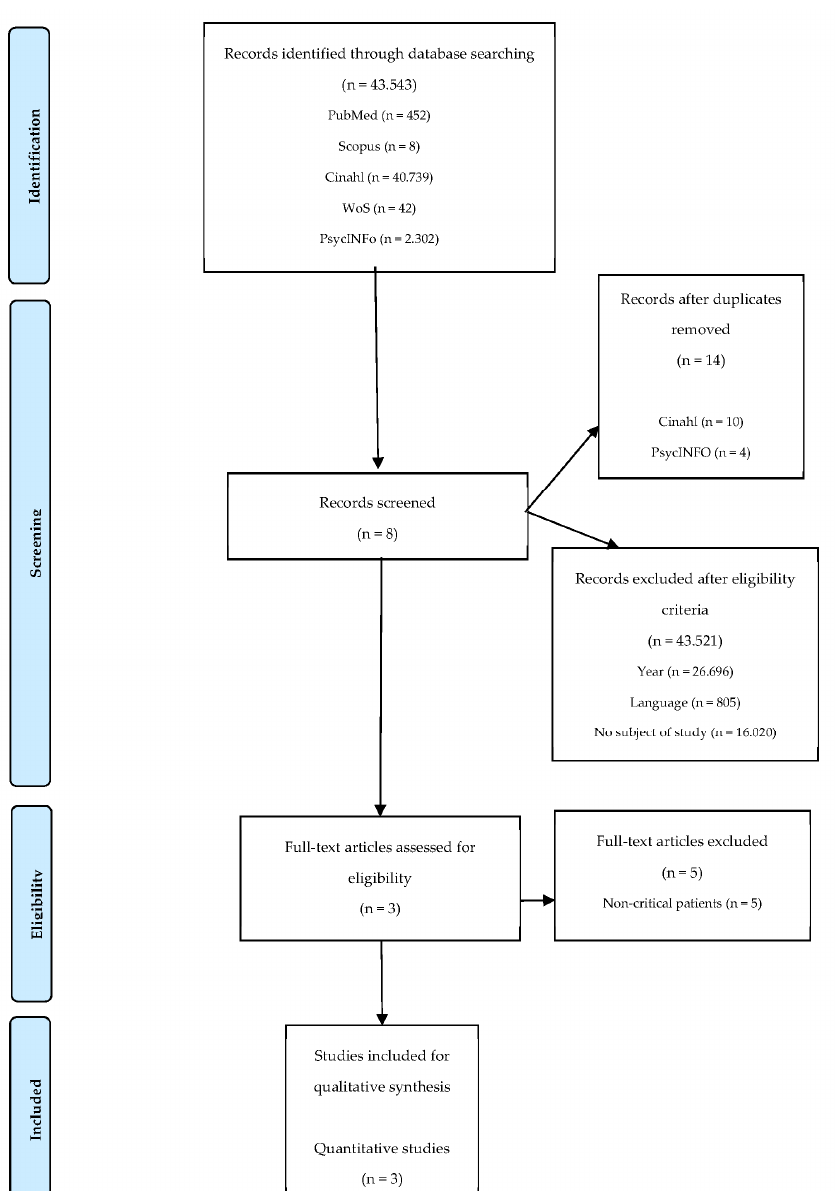
Figure 1. Literature screening and selection based on PRISMA flowchart.